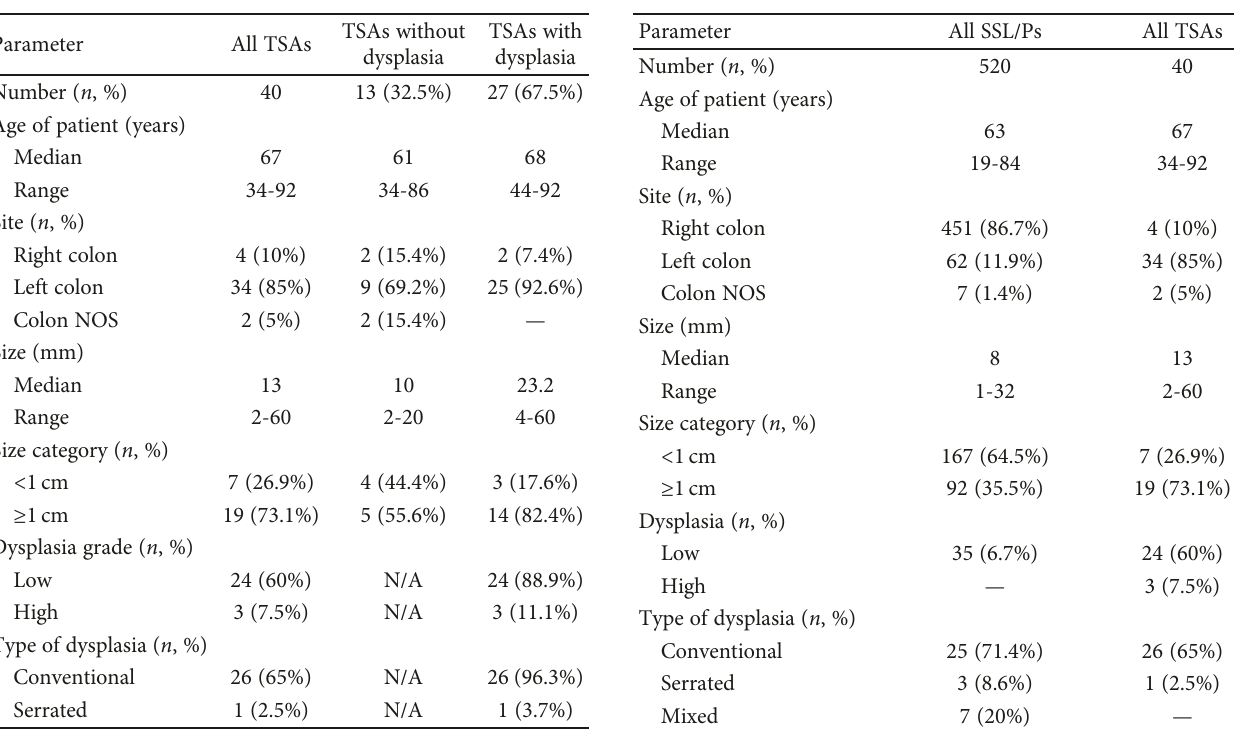
Table 5: Characteristics of SSL/Ps & TSAs identi fi ed over a 12-year period at our